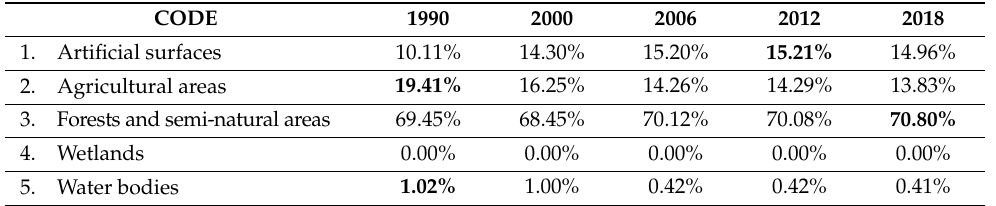
Table 4. Percentage of land-uses according to level 1 of CLC nomenclature in the Autonomous Region of